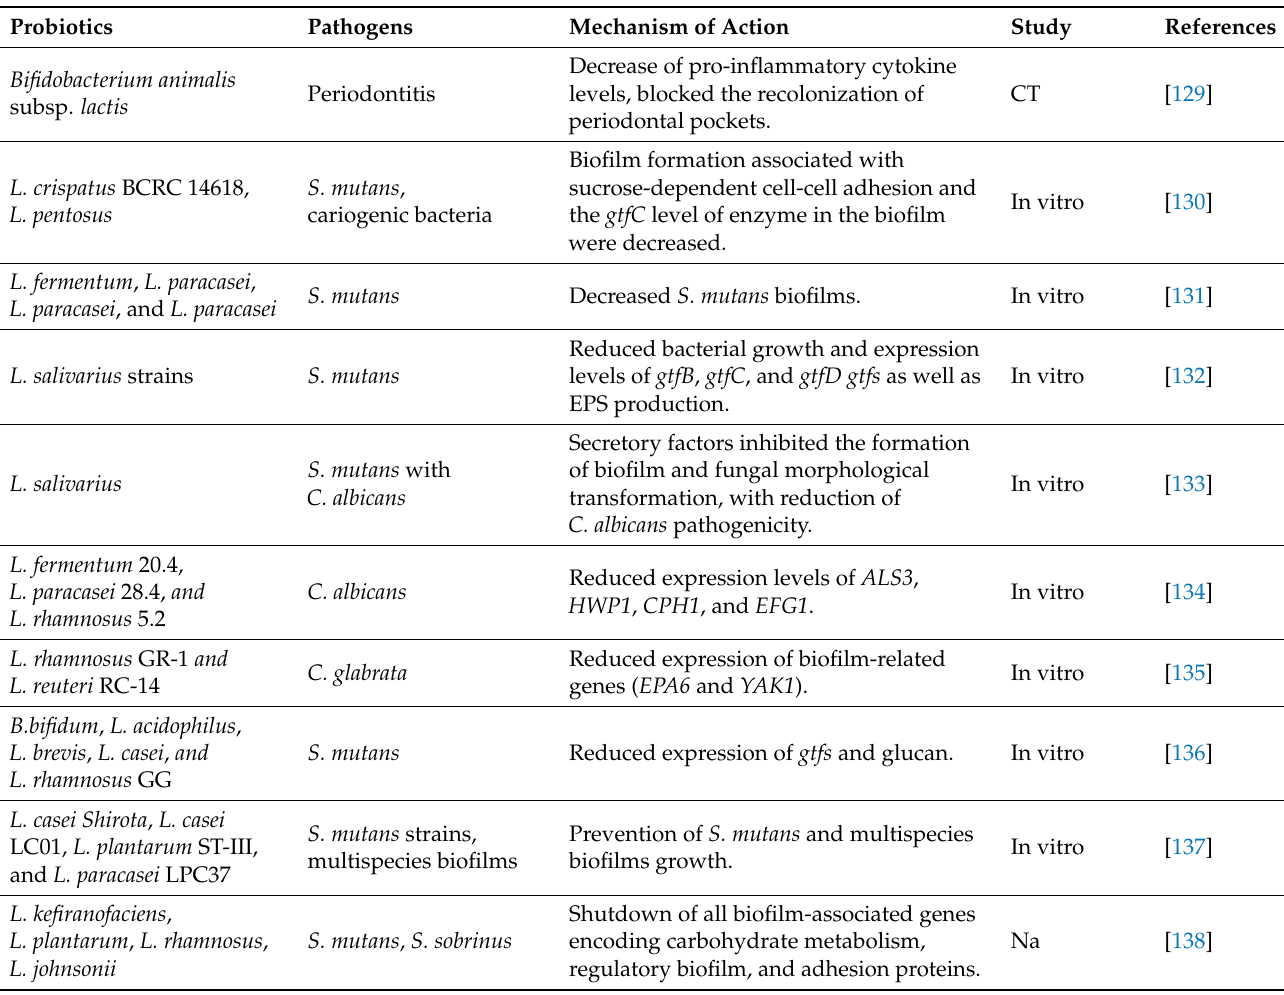
Table 3. This table reports a summary of the mechanisms of action used by some Lactobacillus and Bifidobacterium probiotics to contrast the establishment, growth, or stability of pathogenic